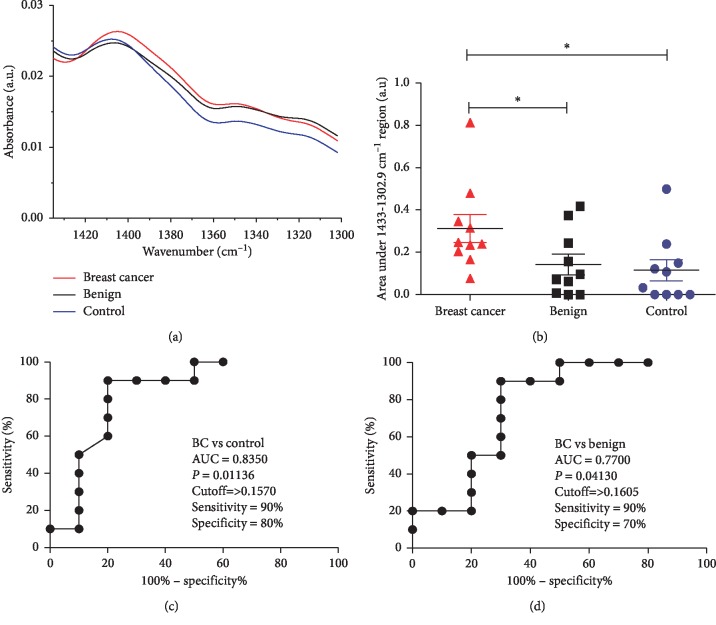
Comparison of the area under the 1433 cm−1 and 1302.9 cm−1 wavenumber region between the three study groups. (a) Average original spectra highlighting the 1433–1302.9 cm−1 region for breast cancer (red line), benign breast disease (black line), and control saliva (blue line). (b) Scatter plot of the 1433 cm−1 and 1302.9 cm−1 region for breast cancer (red), benign breast disease (black), and control saliva (blue). The line represents the mean, and the error bars (whiskers) represent the standard error of the mean (SEM) (∗P < 0.05, pairwise comparison of groups via the Mann–Whitney test). ROC curves made from area under the 1433 cm−1 and 1302.9 cm−1 region for (c) breast cancer vs. control and (d) breast cancer vs. benign breast disease. Results about area under the curve (AUC), P value, cutoff, sensitivity, and specificity are being shown near the ROC curve. Statistically significant differences are represented by ∗ (∗P < 0.05).